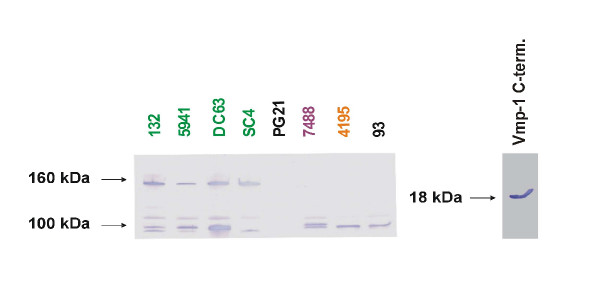
Detection of Vmp-1. Immunoblotting of selected isolates using the polyclonal antisera generated against the C-terminal part of Vmp-1 from isolate 132. Isolates 132, 5941, DC63 and SC4 show a sharp band around 160 kDa, thus demonstrating the expression of Vmp-1 in these isolates. The polyclonal antiserum additionally reacted with multiple bands around 100 kDa. These bands probably corresponds to a ~100 kDa M. hominis protein which previously has been shown to bind Ig-molecules unspecifically. This protein has not been observed in PG21. The right panel shows the coomassie stained, recombinant Vmp-1 C-terminal fragment used for immunization.